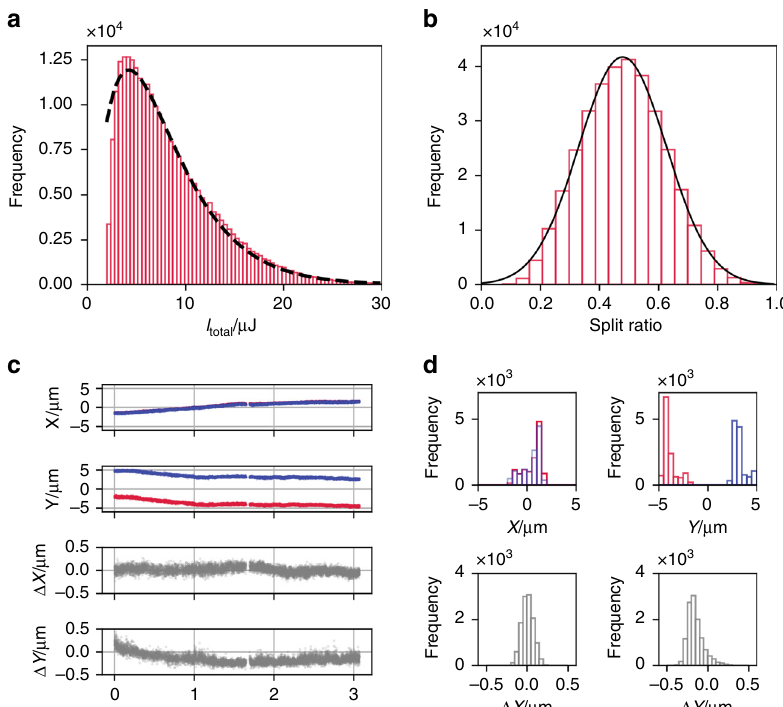
Fig. 2 Statistics of self-seeded XFEL pulses after split-and-delay optics. a A pulse energy distribution at sample position for 280,815 shots (red bar). The dashed line represents the best fi t to a gamma distribution. b A histogram of the split ratio R for 340,732 shots. The solid line represents the best fi t to a Gaussian distribution for the average = 0.48 and the standard deviation = 0.15. c Time-courses of X-ray beam position of two sub-pulses at the sample position, X and Y , and their relative position, Δ X and Δ Y. Δ X (or Δ Y ) were calculated by subtracting X (or Y ) of the variable-delay branch (blue) from X (or Y ) of the fi xed-delay branch (red). d The histograms of X , Y , Δ X, and Δ Y . The position of two X-ray pulses was shifted in the Y direction to distinguish